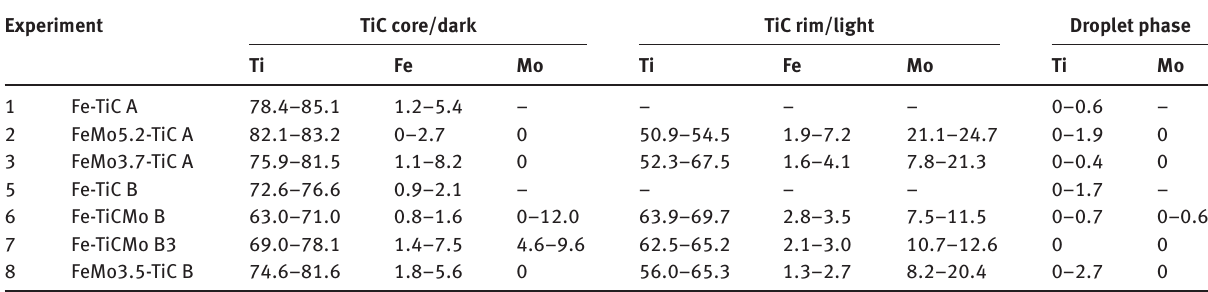
Table 4: Average analysis of TiC particles and the alloy phase (droplet material) on the droplet side (in mass%) Experiment